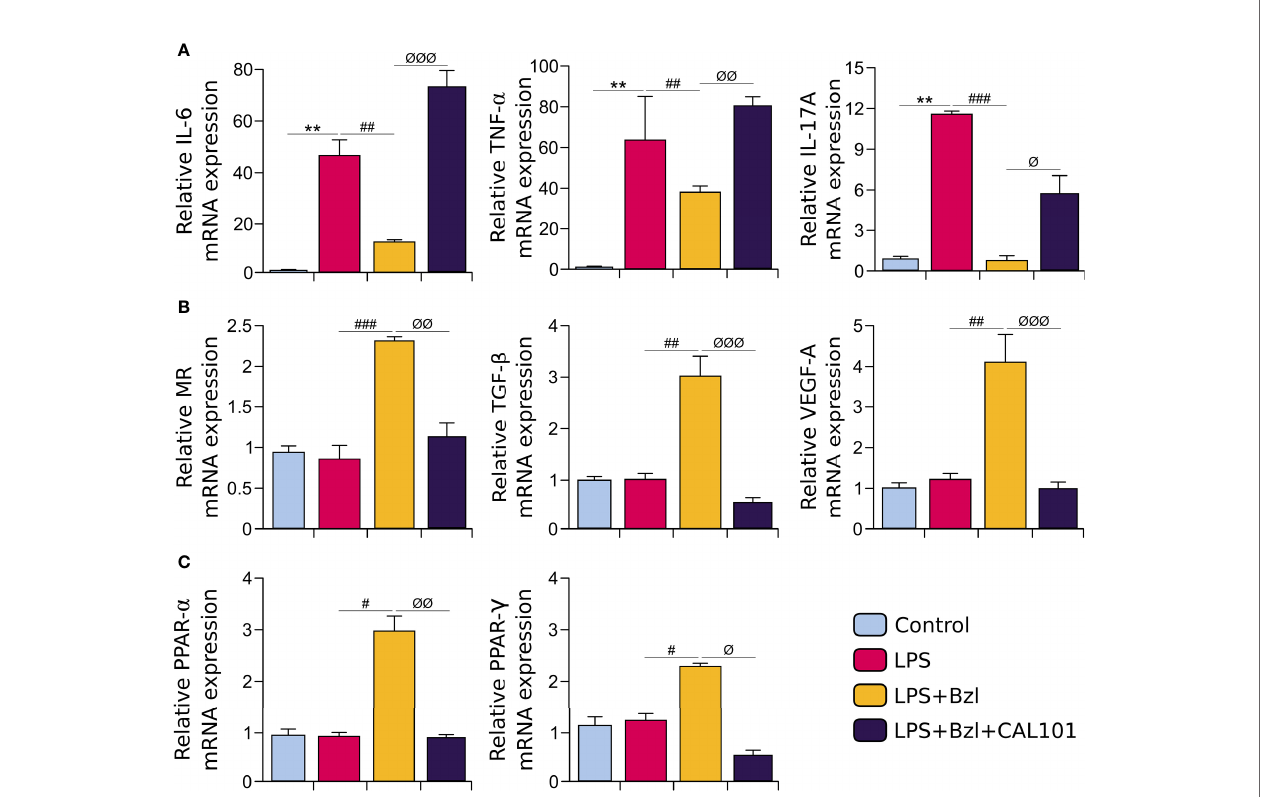
FIGURE 9 | RAW 264.7 macrophages were treated with 10 m M CAL-101, a speci fi c inhibitor of p110 d , the catalytic subunit of PI3K d isoform, 30 min before the addition of 15 m M benznidazole (Bzl). Cells were stimulated with 10 µg/mL LPS 30 min after Bzl treatment. After 4 h, IL-6, TNF- a and IL-17A mRNA levels were analyzed by RT-qPCR and normalized against b -actin mRNA (A) . After 24 h, Mannose Receptor (MR), TGF- b , VEGF-A (B) , PPAR- a and PPAR- g (C) mRNA levels were analyzed by RT-qPCR and normalized against b -actin mRNA, and after 48 h relative Arginase I protein expression was determined by Western blot with a speci fi c antibody and normalized against b -actin (B) . Results are expressed as the mean of 3 independent experiments (n=3, 5 replicates/treatment) ± SEM. **P < 0.001 vs. control cells; # P < 0.05, ## P < 0.001, ### P < 0.0001 vs LPS-stimulated cells . f P < 0.05, ff P < 0.001, fff P < 0.0001 vs. Bzl-treated and LPS-stimulated